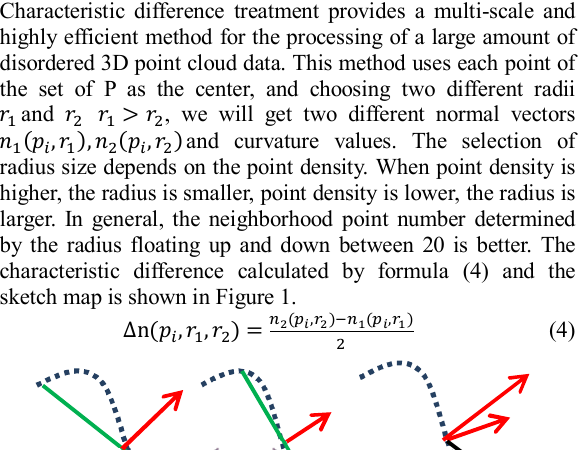
Figure 2. The flow chart of gully segmentation